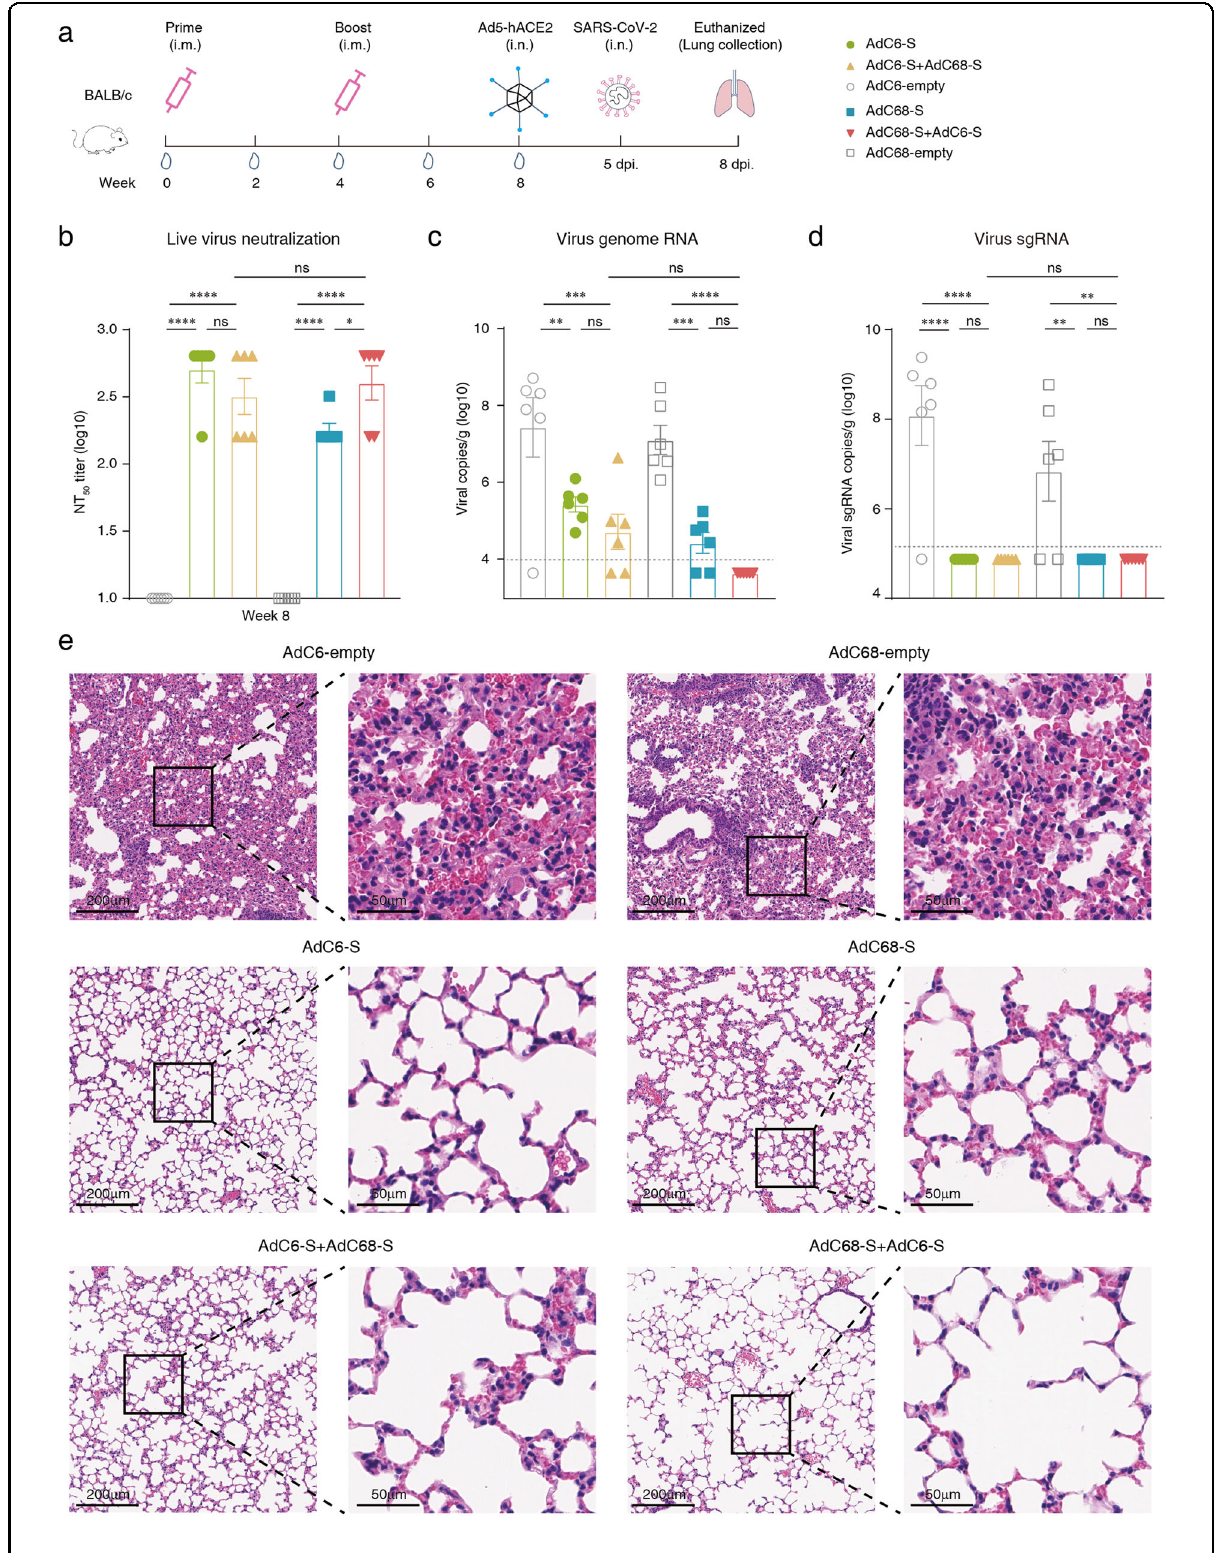
Fig. 3 (See legend on next